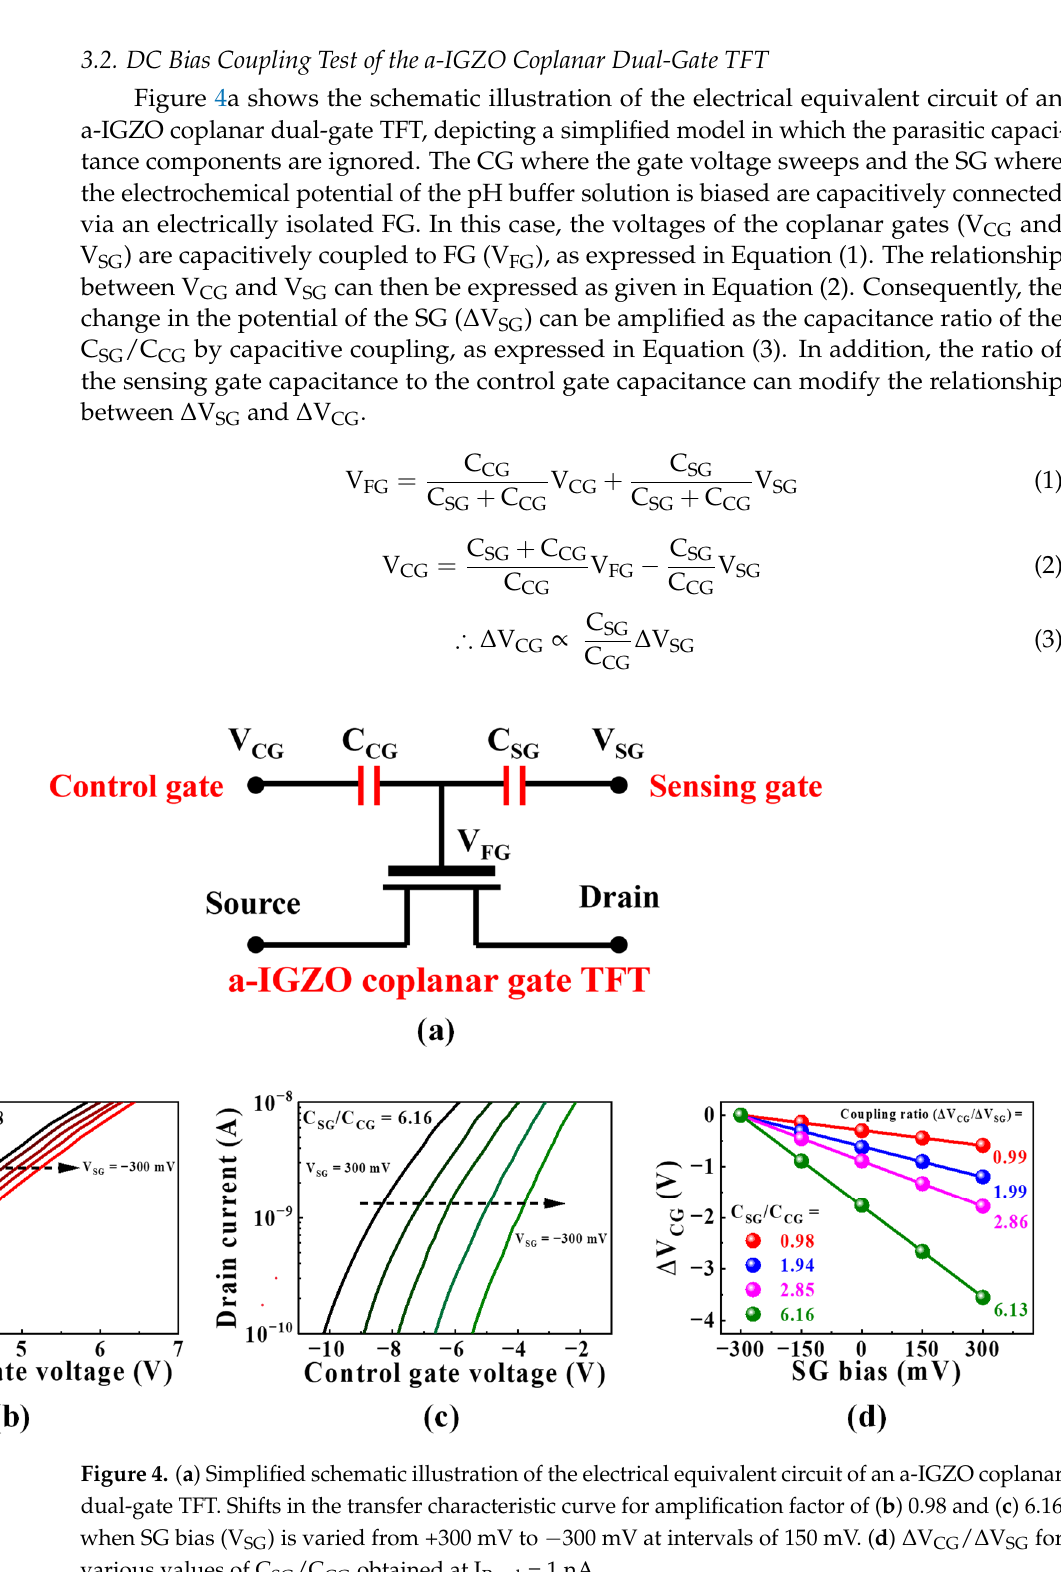
Table 1. Amplification factors ( Δ V CG / Δ V SG ) obtained from the DC bias test of the a-IGZO coplanar dual-gate TFT.